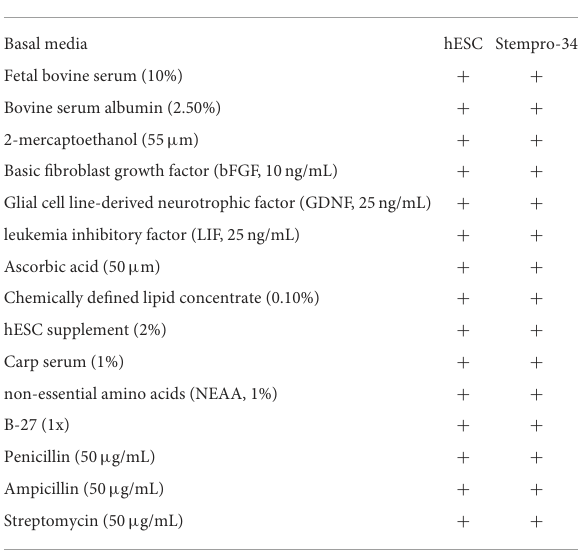
TABLE 1 Components of cell culture